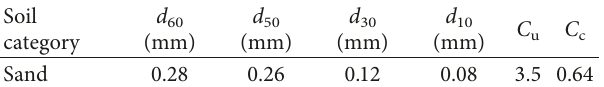
Table 1: Sand gradation constants.